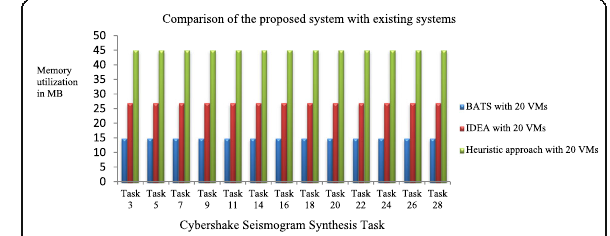
Fig. 12 Memory utilization for Cybershake